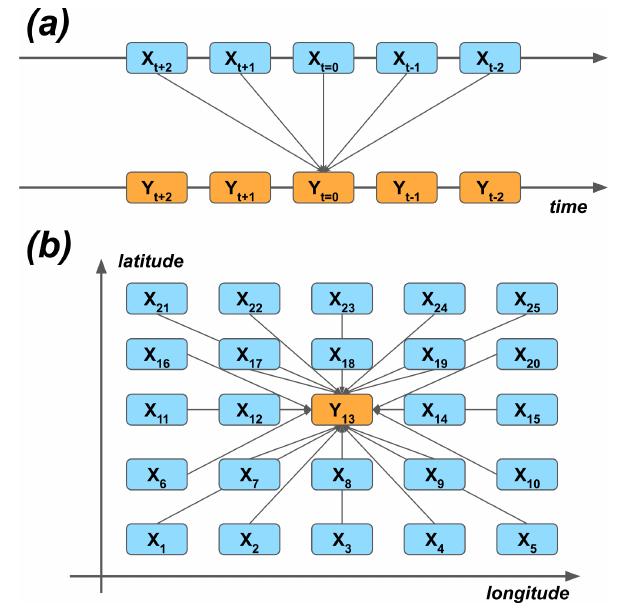
Figure 2. The principle of using (a) temporal lagging and (b) spatial neighborhoods of predictor variables X to model the target variable Y . The numbering of the (a) lags and (b) grid cells corresponds to the lags and neighbors of the ERA5 data used in the